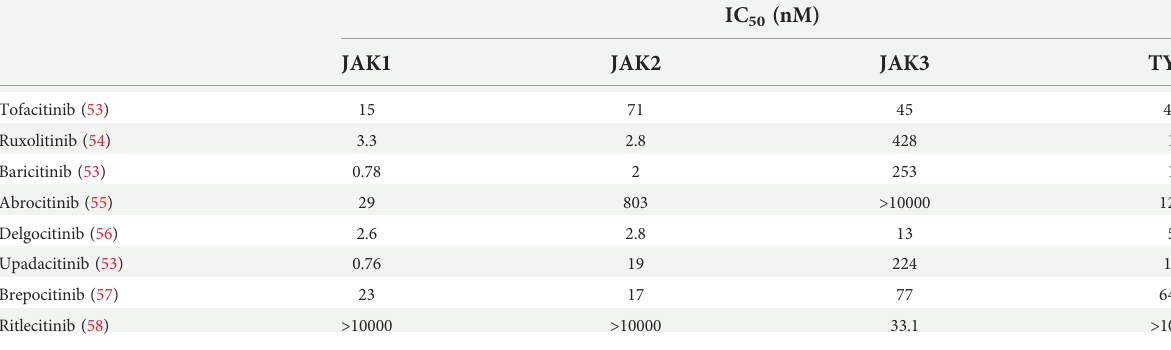
TABLE 1 JAK inhibitors with documented ef fi cacy for treating